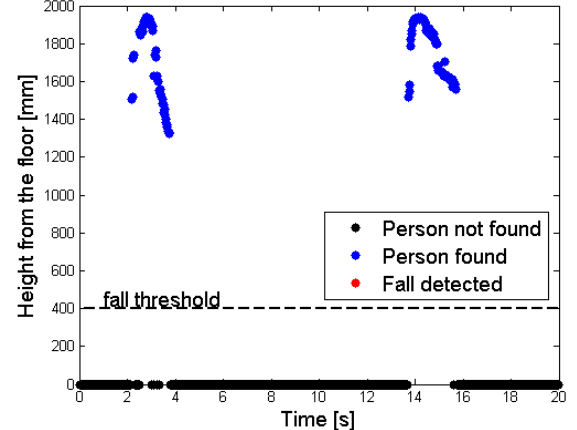
Figure 14. Time sequence of the depth values assumed by the person’s central point ( cp parameter), in the complex scenario, without the RF frame: the fall event is not